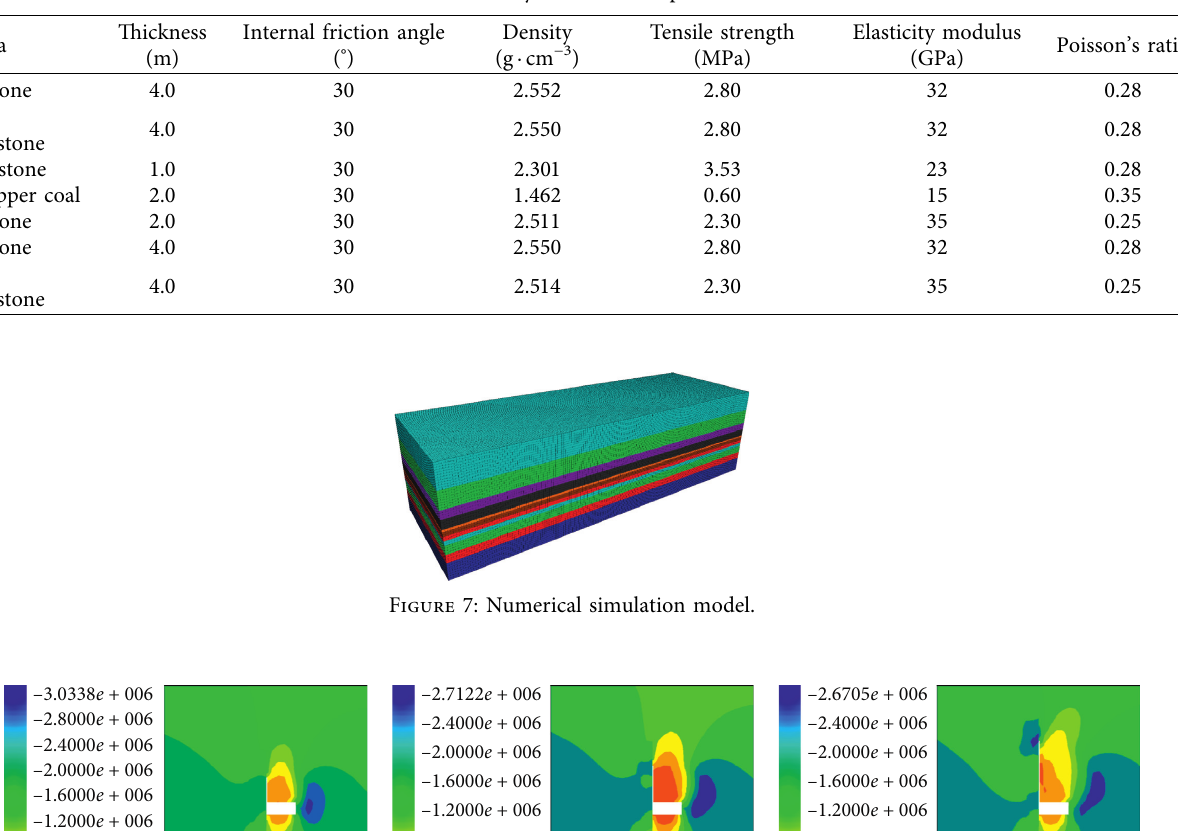
Table 1: Rock layer mechanical parameters.